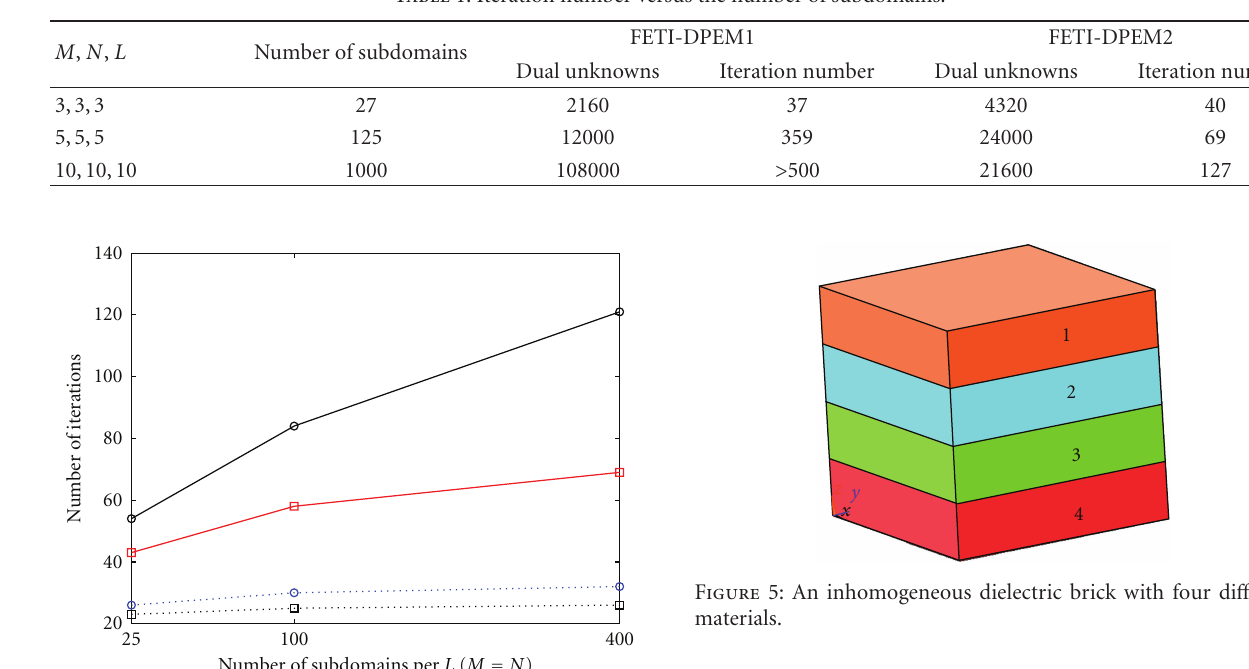
Table 1: Iteration number versus the number of subdomains.